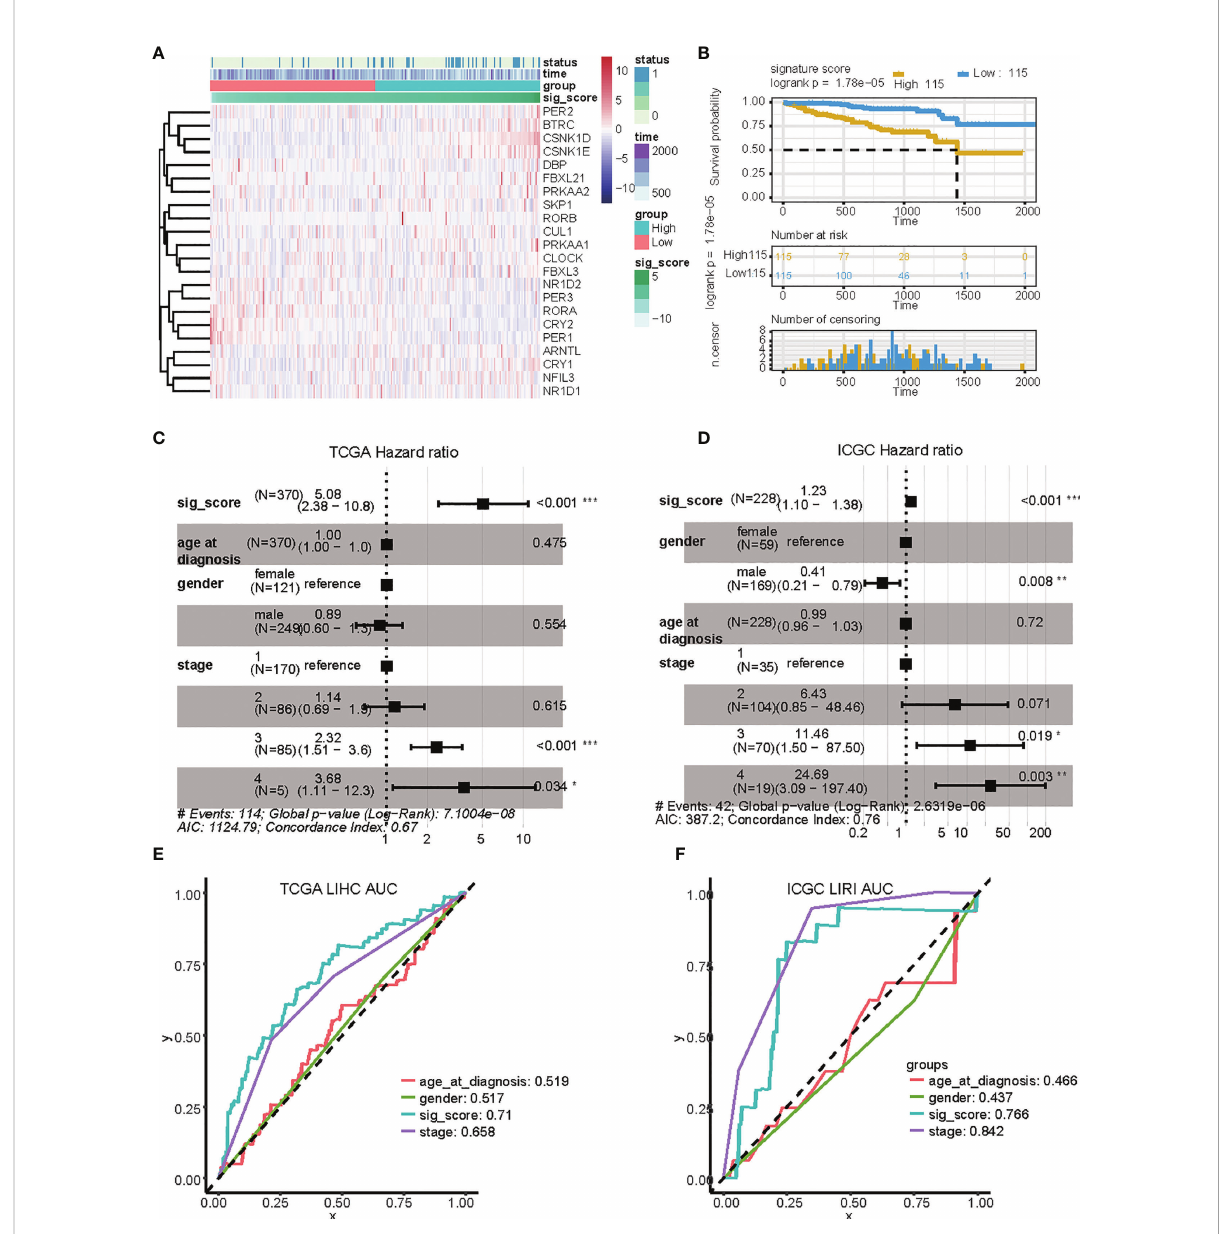
FIGURE 3 Validation of the risk score based on four signature genes from the ICGC dataset. (A) Distribution and expression of circadian-related genes based on the risk scores in the ICGC dataset. (B) Kaplan Meier curves for the OS of patients in the high-risk and low-risk groups in the ICGC dataset. (C, D) Multivariate Cox regression analyses of factors affecting OS in the TCGA LIHC cohort (C) and in the ICGC LIRI dataset (D) . (E, F) Time-dependent ROC analyses indicated that risk score had greater predictive value than other clinical features for 1-year OS in TCGA LIHC and ICGC LIRI. ROC, receiver operating curve; *, P < 0.05; **, P < 0.01; ***, P <